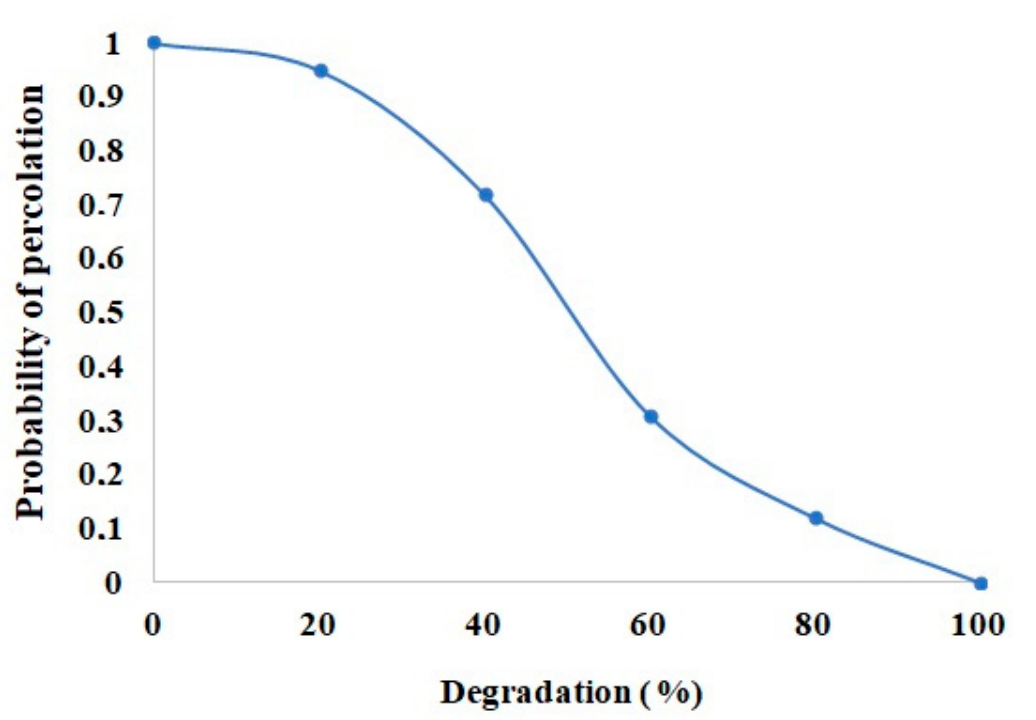
Figure 6. Dependence of percolation probability on the degradation of organic matter of fractal structure.